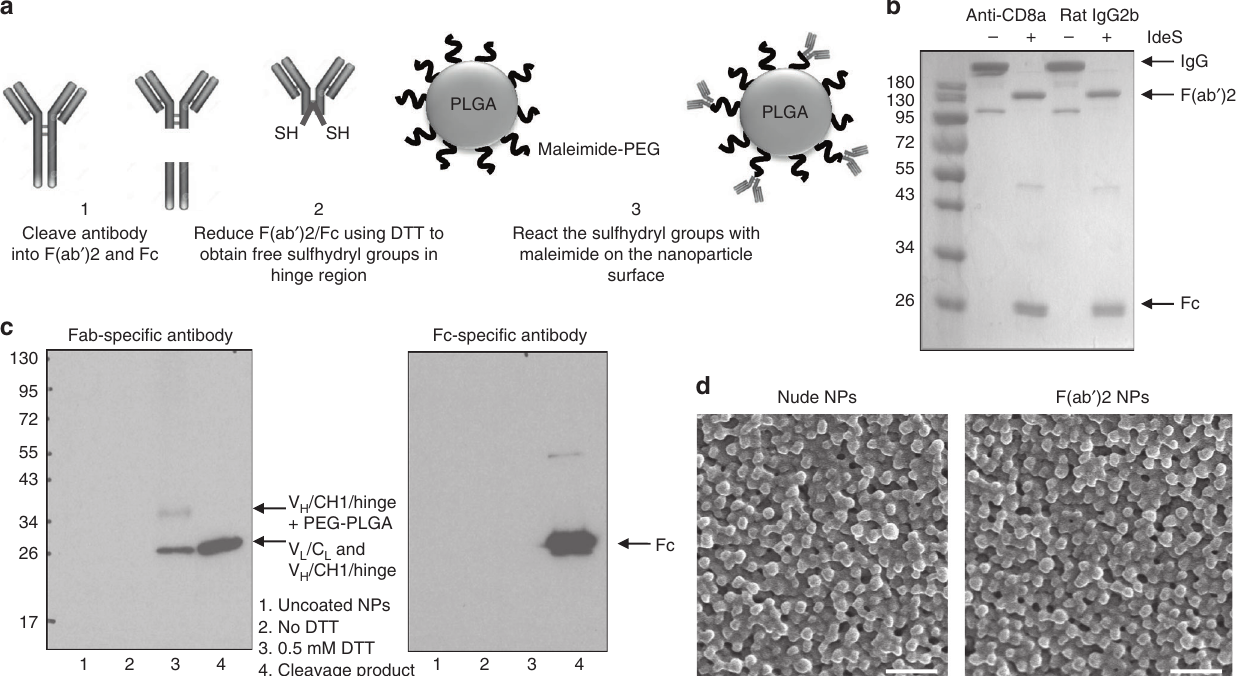
Fig. 1 Optimization of F(ab ’ )2 conjugation to polymeric nanoparticles. a Scheme of antibody fragment conjugation to the surface of pre-formulated maleimide-functionalized PEG-PLGA polymeric nanoparticles (NPs). b A non-reducing SDS – PAGE gel stained with Coomassie Brilliant Blue is shown following IdeS-mediated cleavage of anti-CD8a and rat IgG2b isotype control antibodies. c A Western blot following reducing SDS – PAGE of CD8a- targeting nanoparticles developed with Fab-speci fi c (left panel) or Fc-speci fi c antibodies (right panel); lane 1: uncoated nanoparticles, lane 2: nanoparticles without antibody reduction before conjugation, lane 3: anti-CD8a nanoparticles with the antibody reduced using 0.5 mM DTT before conjugation, lane 4: anti-CD8a F(ab ’ )2 and Fc cleavage product as a positive control. d Scanning electron microscopy images of blank NP formulations before and after F(ab ’